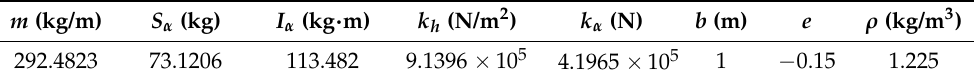
Table 1. Parameter values for the typical section model. The structural parameters m , S α , I α , k h and k α are given per unit span, ρ is the air density, e the relative position of the elastic axis and b the half chord length.